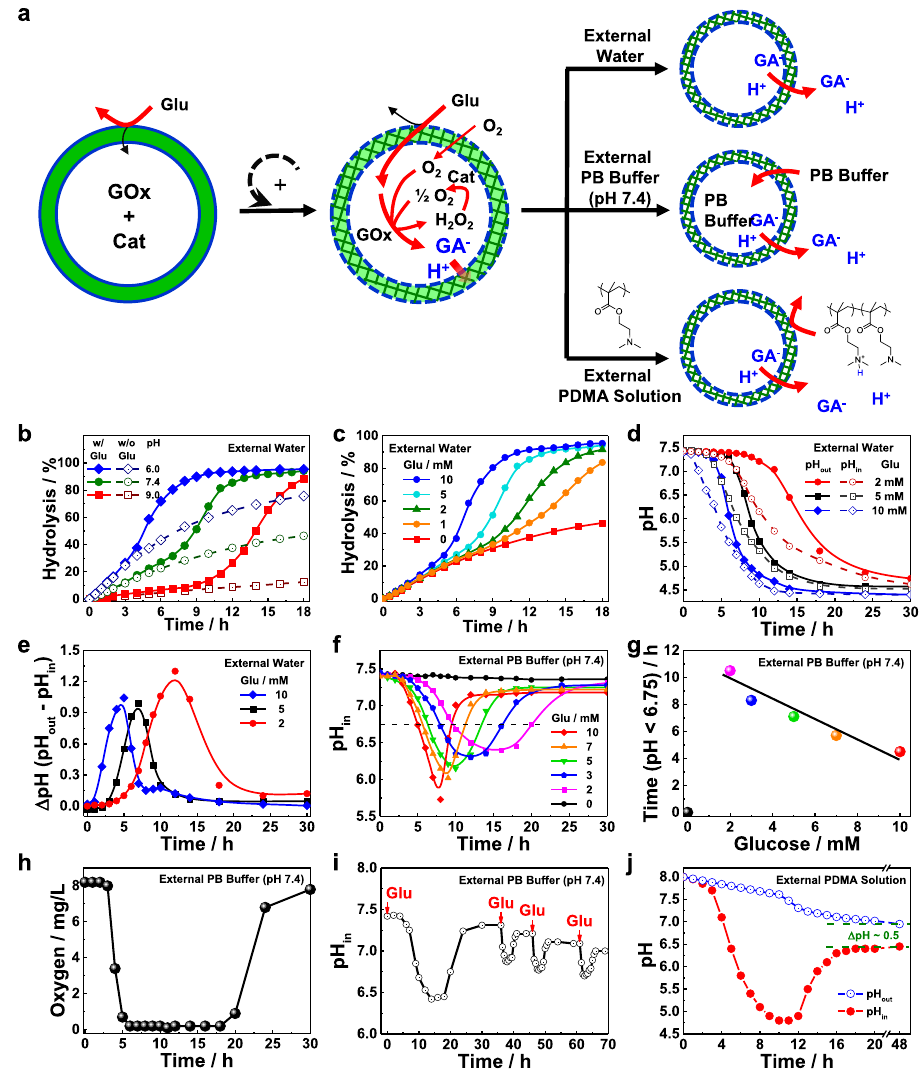
Fig. 4 Construction of local transient acidic milieu and pH oscillation within polymersome interiors. a Schematics of pH-oscillating nanosystems constructed from BPN polymersomes encapsulating glucose oxidase (GOx) and catalase (Cat) in varying external media including pure water, PB buffer (pH 7.4), and an aqueous solution of cationic polyelectrolyte (PDMA). Incubation time-dependent evolution of hydrolysis extents of imine linkages ( b , c ), local pH of polymersome interior, pH in , and external pH, pH out ( d ), and pH discrepancy, Δ pH, between inside and outside milieu ( e ) recorded for BPN 23 polymersomes encapsulating GOx and Cat enzymes in the absence and presence of glucose ( b , 5 mM; c – e , 0~10 mM), with the initial external milieu set